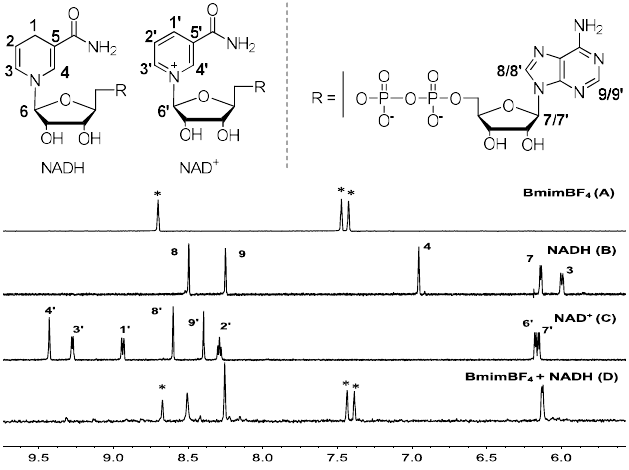
Figure 3. 1 H NMR (600 MHz, D 2 O, 298 K) (δ: ppm) study. ( A ) BmimBF 4 ; ( B ) NADH; ( C ), NAD + ; ( D ) a mixture of NADH and BmimBF 4 (molar ratio = 1:1); * signals for imidazolium C(sp 2 )-H.